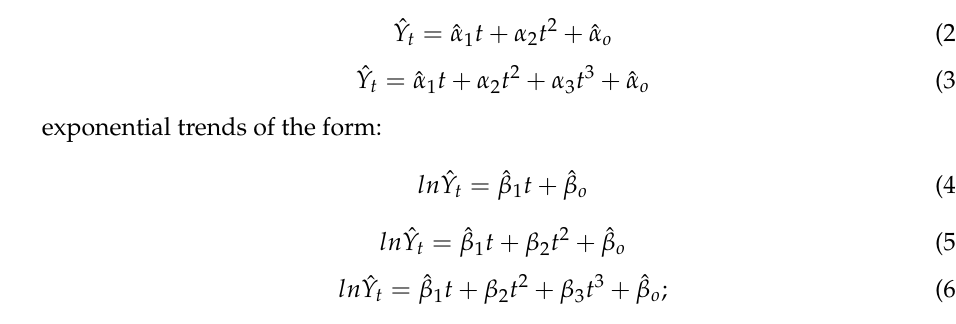
Comparison of the growth rate of the studied phenomenon with the help of a distance